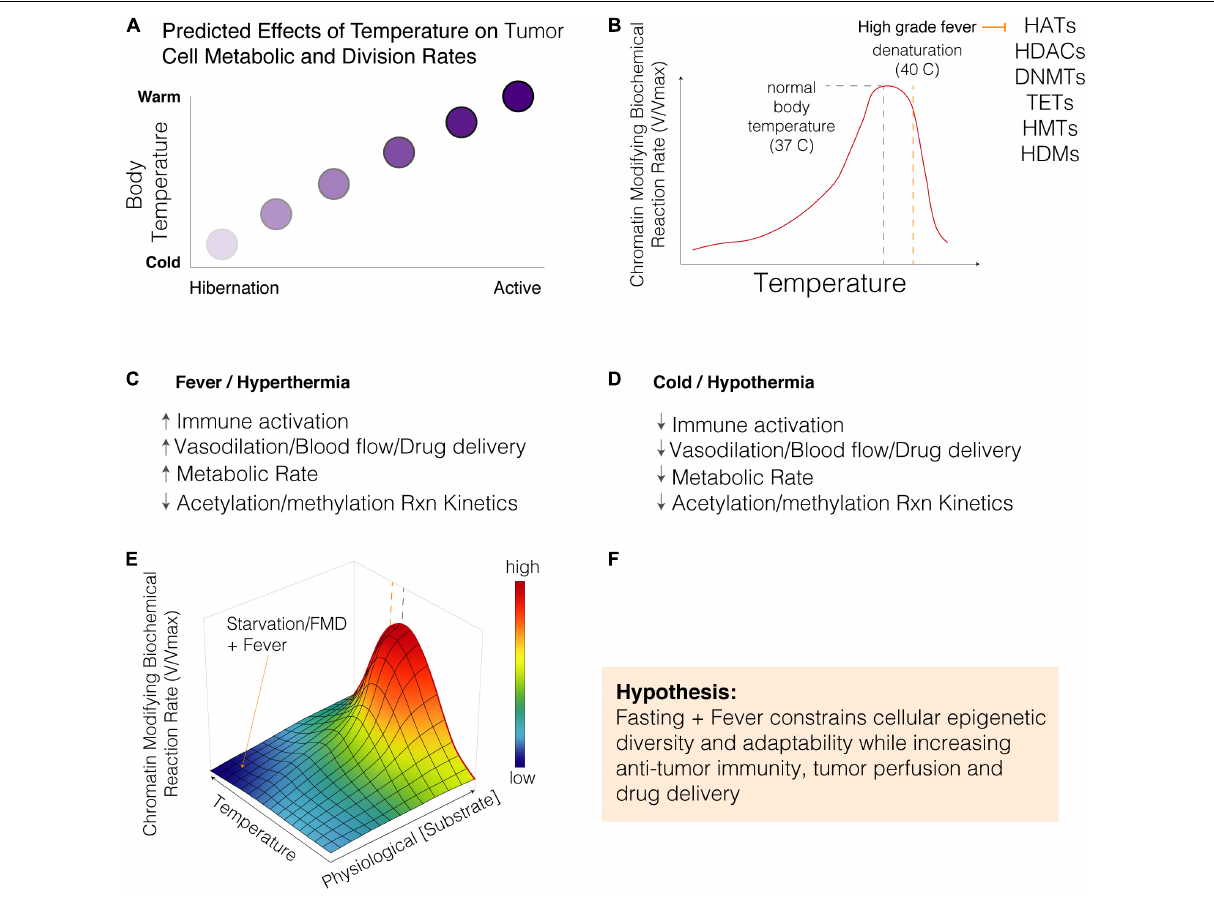
FIGURE 6 | Fever/hyperthermia is predicted to block cellular hypometabolic states and constrain epigenetic diversity and adaptability by impairing enzyme activity. (A) Cold stress depresses metabolic rate and promotes hypometabolic states, while warming increases metabolic rates. Warming could help block hibernation-like states in cancer cell subpopulations. (B) Fever/hyperthermia triggers rapid decreases in biochemical reaction rates due to denaturation of enzyme active sites. Thus, fever-level body temperatures may help inhibit the activity of chromatin-modifying enzymes and block epigenetic diversity and adaptability. (C,D) Compare the effects of hyperthermia versus hypothermia and suggest that hyperthermic treatments could have multiple beneficial effects for cancer elimination. (E) Plot shows that combining starvation/FMD with fever/hyperthermia could be a potent intervention constraining tumor cell epigenetic diversity and adaptability. (F) A hypothesis for the benefits of combining starvation/FMD with